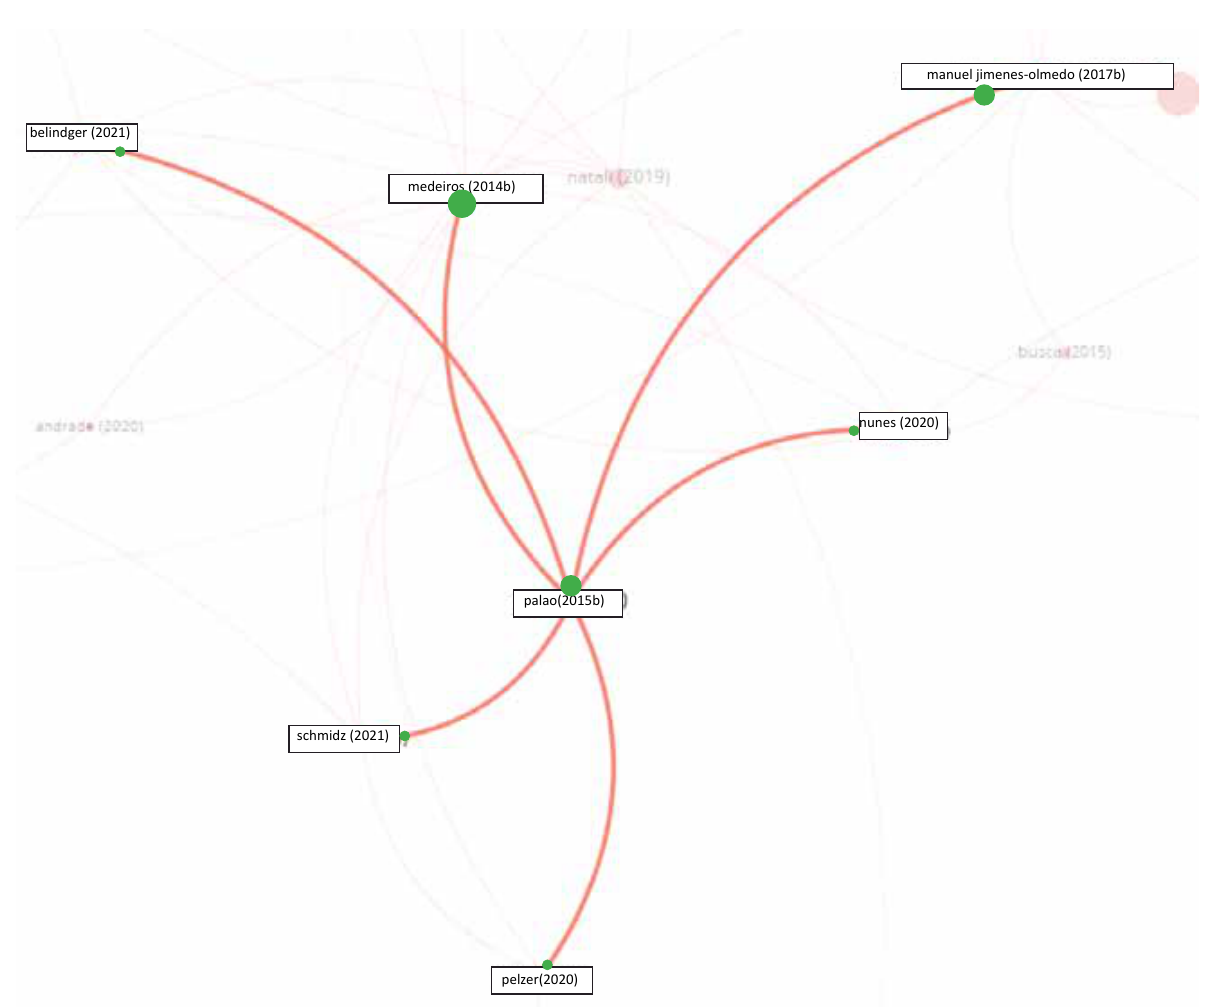
Figure 5. The relationship between a group of documents, 2014-2021, a fragment of Fig. 3 (Source: Own research based on extracted data from WoS and analyzed with VOSviewer;